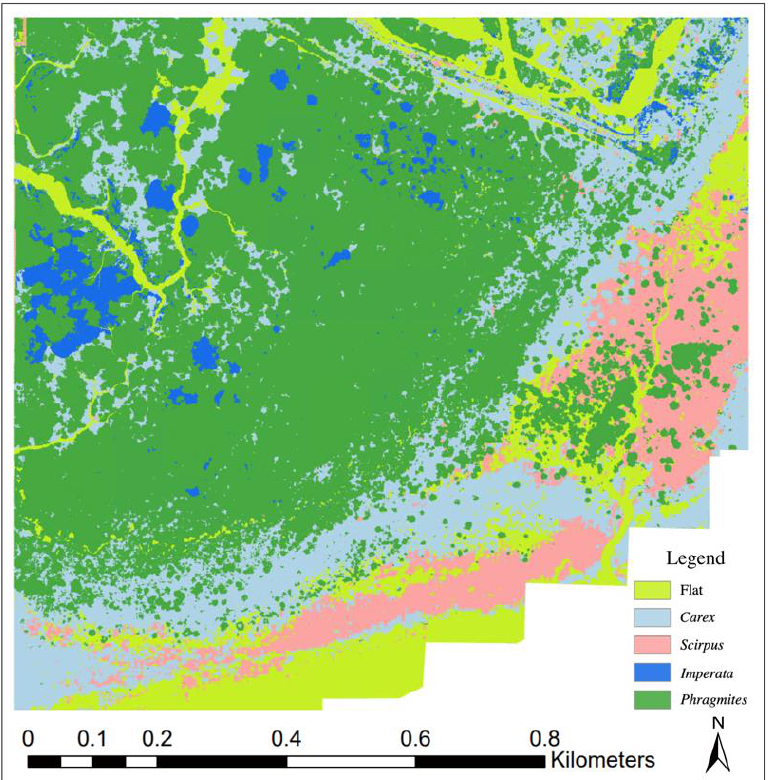
Figure A3. Thematic map of DL classification in the study area.